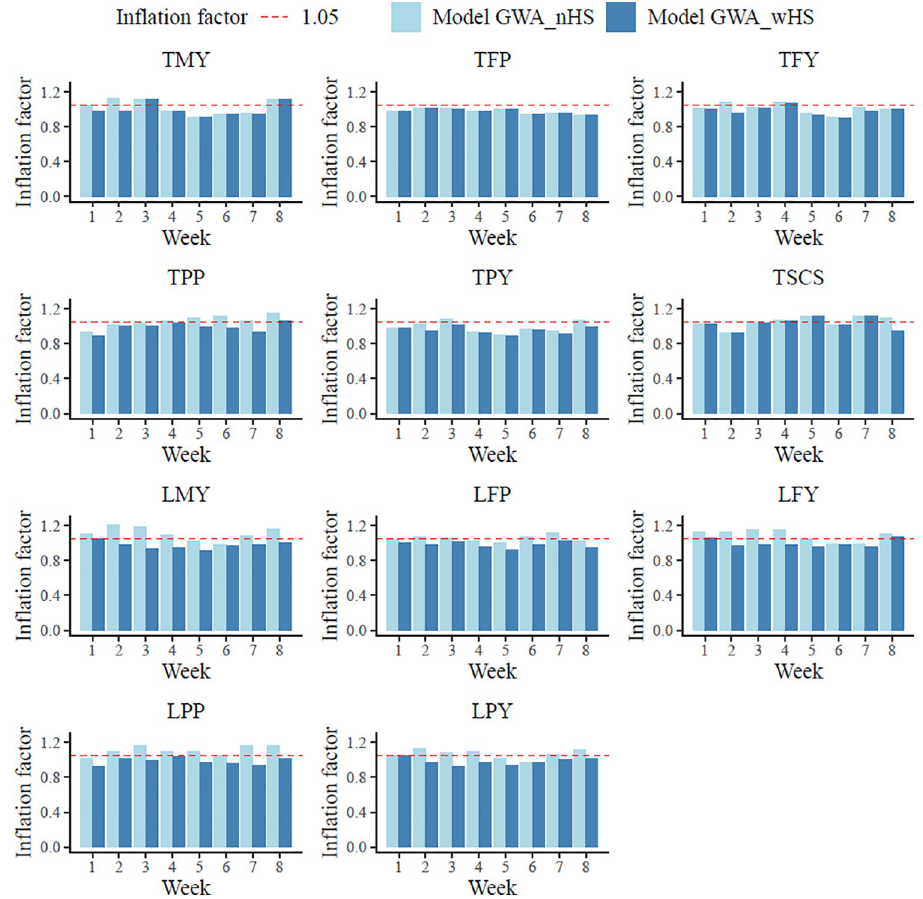
Fig 2. Inflation factors for interaction effects from GWAS models with (GWA_wHS) and without genotype by heat stress interaction (GWA_nHS) during the last eight weeks of pregnancy. Dotted line = inflation factor of 1.05; TMY = first test-day milk yield; TFP = first test-day fat percentage; TFY = first test-day fat yield; TPP = first test-day protein percentage; TPY = first test-day protein yield; TSCS = first test-day somatic cell score; LMY = first lactation milk yield; LFP = first lactation fat percentage; LFY = first lactation fat yield; LPP = first lactation protein percentage; LPY = first lactation protein yield.